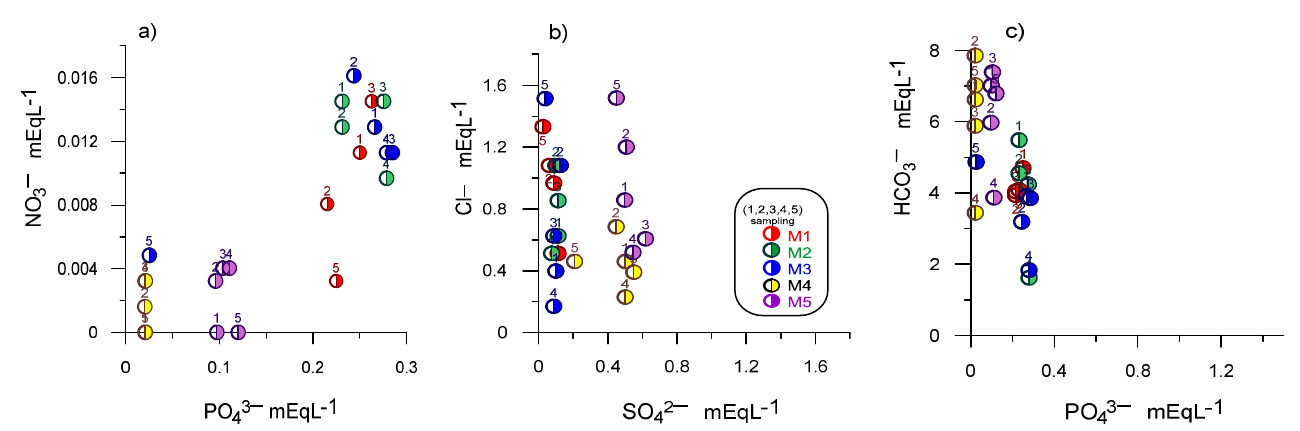
Figure 7. Scatter plot for the hydrogeochemical evolutionary process, ( a ) scatter plot NH 4+ vs. SO 42− , ( b ) scatter plot Cl − vs. SO 42− , ( c ) scatter plot HCO 3− Vs. SO 42−.